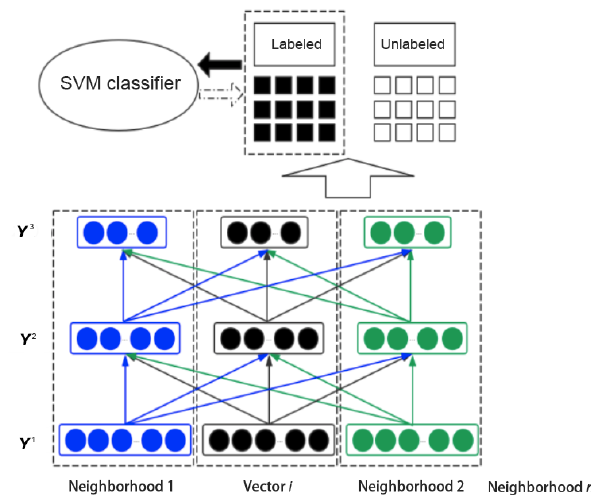
Fig. 2 Framework of